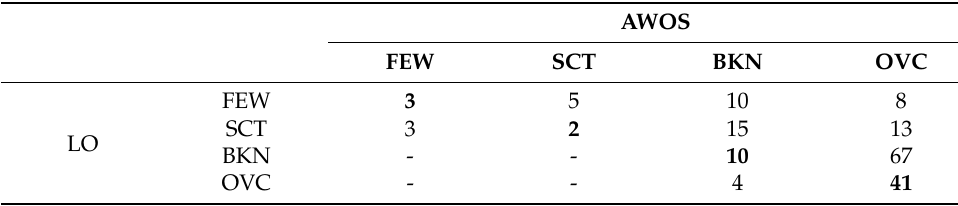
Table 2. A comparison of the maximum cloud cover values determined by the AWOS and the local observers (LO). The exact matches along the diagonal are indicated in bold.